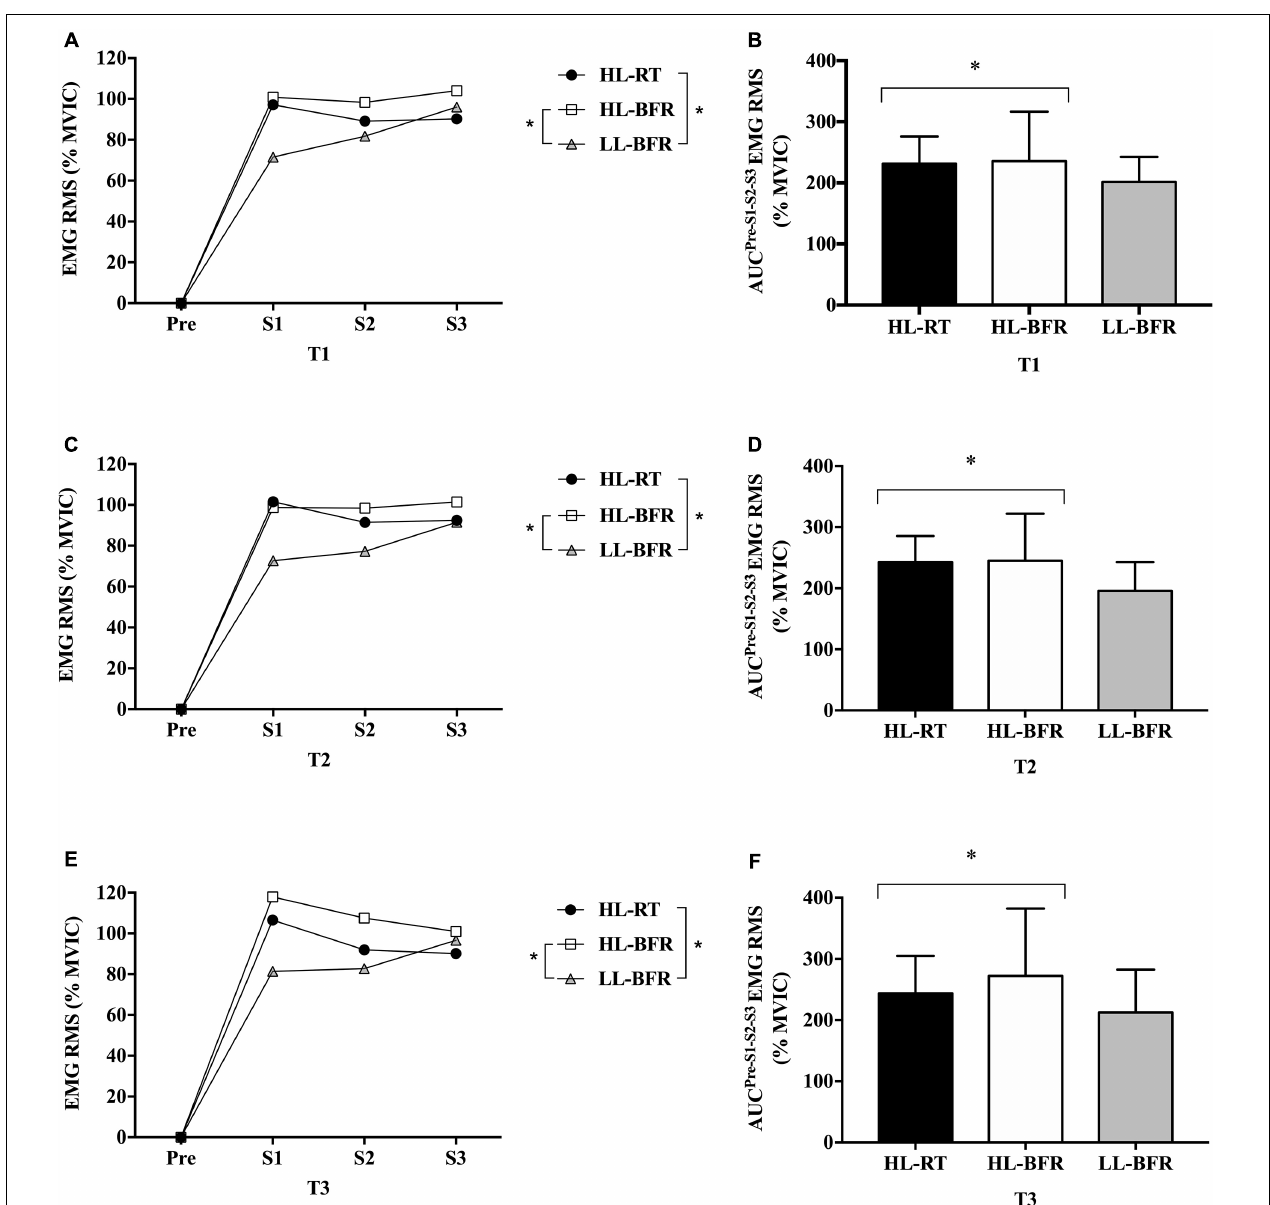
FIGURE 2 | Normalized electromyographic (EMG) root mean square (RMS) values from the resistance training session (Pre [Before the beginning of the exercise], set 1 [S1], set 2 [S2], and set 3 [S3]) at baseline (T1, A ), after 5 (T2, C ) and 10 weeks (T3, E ) for the high-load resistance training (HL-RT), high-load resistance training with blood flow restriction (HL-BFR) and low-load resistance training with blood flow restriction (LL-BFR) protocols. EMG RMS values also are reported as area under the curve (AUC) from the entire resistance training session at T1 (B) , T2 (D) , and T3 (F) for the HL-RT, HL-BFR and LL-BFR protocols. ∗ Significantly different from LL-BFR (main protocol effect, P < 0.01). Values presented as mean ±